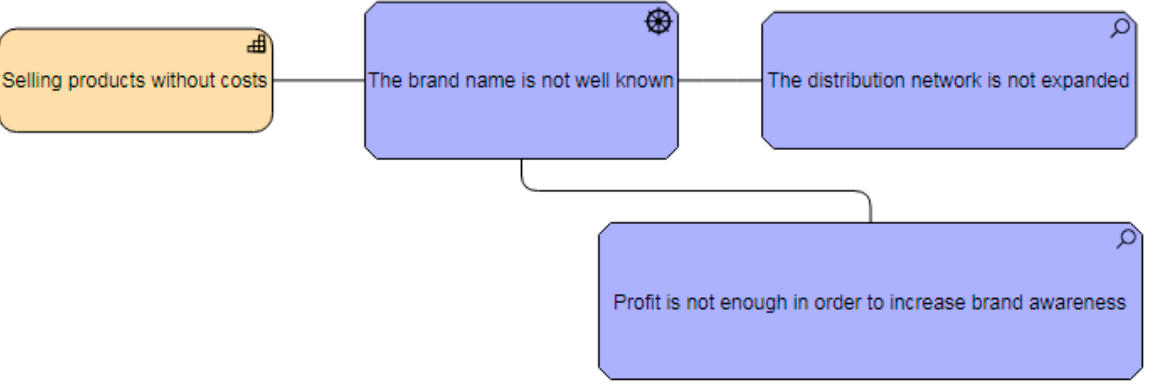
Figure 8. The link between capabilities and external factors.